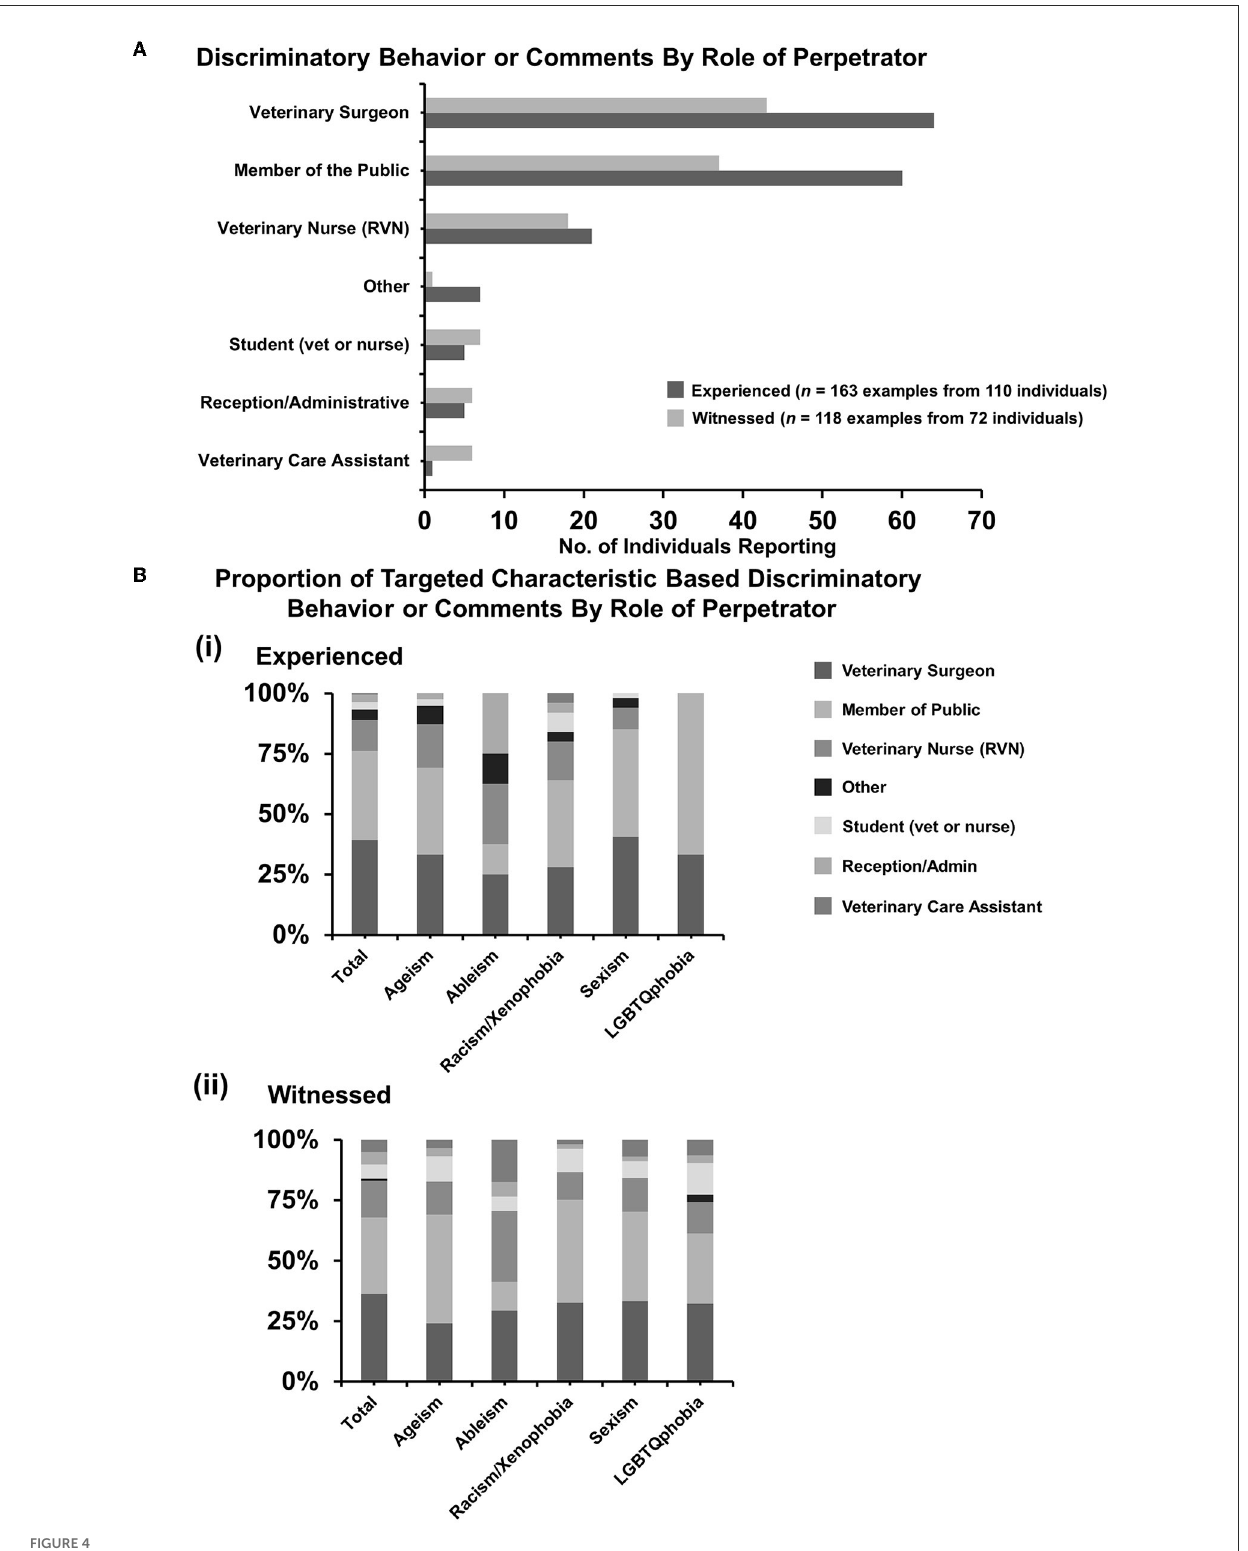
FIGURE4 Discriminatory behavior or comments experienced or witnessed by role of perpetrator. Respondents who had responded “yes” or “not sure” were asked questions to select the role(s) of the perpetrator(s) of the discrimination experienced or witnessed. Some respondents had experienced multiple incidents involving sometimes more than one individual in different roles. (A) Bar graph demonstrating a number of individuals reporting specific roles of perpetrators for experienced ( n = 163 examples from 110 individuals) and witnessed ( n = 118 examples from 72 individuals) discrimination. [ (B) i, ii] Percentage proportions of examples by discrimination types. Statistical significance was determined by Pearson’s chi-squared test of association between total proportions and matching proportions for each category. No statistically significant associations were identified. In addition, 95% confidence intervals have been left off for figure